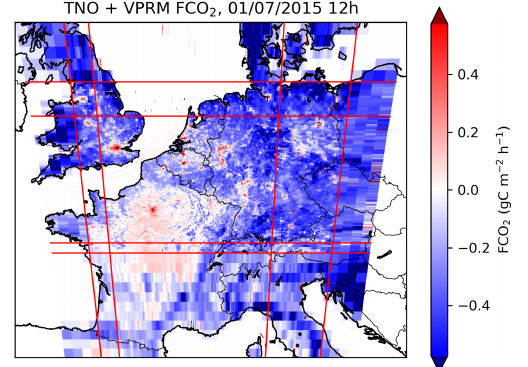
Figure 1. CO 2 flux map (based on values from the TNO inven- tory and VPRM simulations for 1 July 2015 at 12:00UTC) over the atmospheric transport modelling grid. The red lines delimit the spa- tial resolution changes within the domain (from 2 to 10km and then 50km from the middle to the edges of the domain).